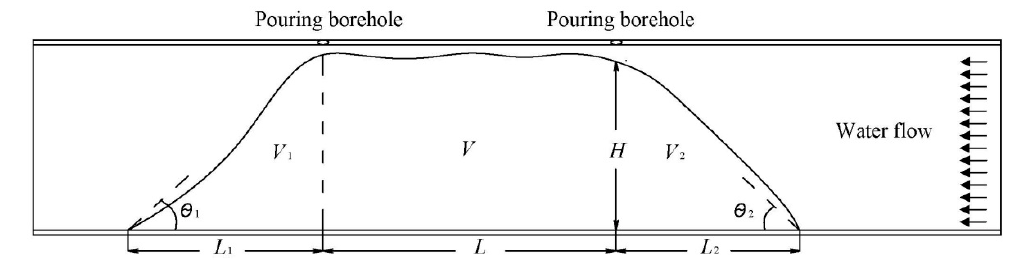
Figure 9. Schematic diagram of optimum spacing between boreholes.